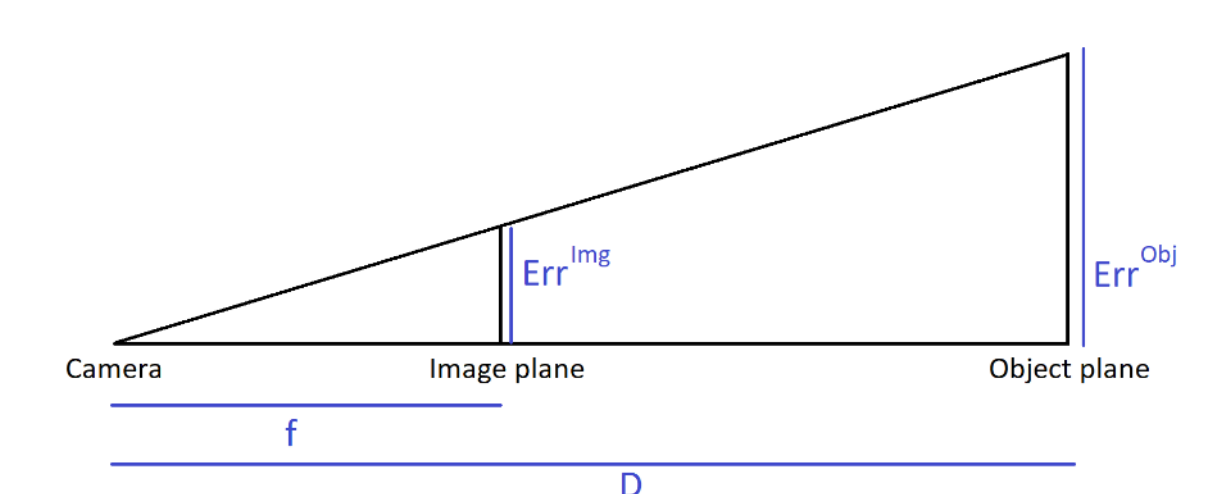
Figure 2. The pinhole camera model, permitting a correspondence between image coordinates and object coordinates. F—focal distance; D—object to camera distance; Err Img —error on image plane; Err Obj —error on object plane. F and Err Img are usually expressed in pixels, while D and Err Obj are expressed in meters.